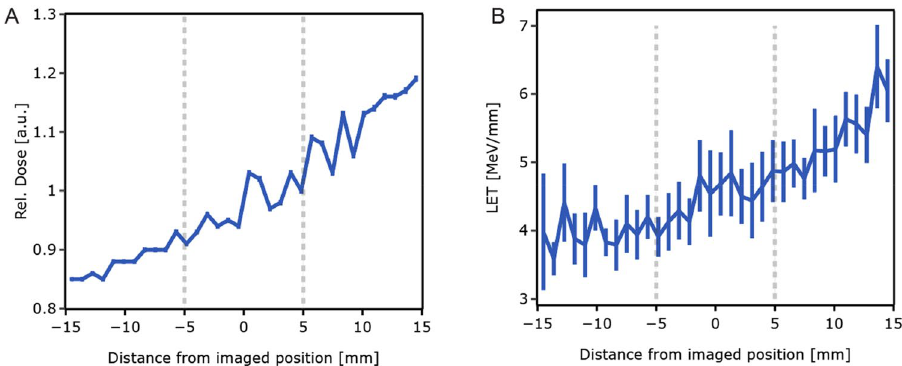
Figure 2. ( A ) Simulated dose distribution across the bottom of the cell culture vessel, in the beam direction, relative to the dose measured with the Markus chamber. ( B ) Simulated dose-averaged LET along the bottom of the cell culture vessel in the beam direction. For both, the origin corresponds to the centre of the imaged glass window. The vertical lines mark the boundary of the